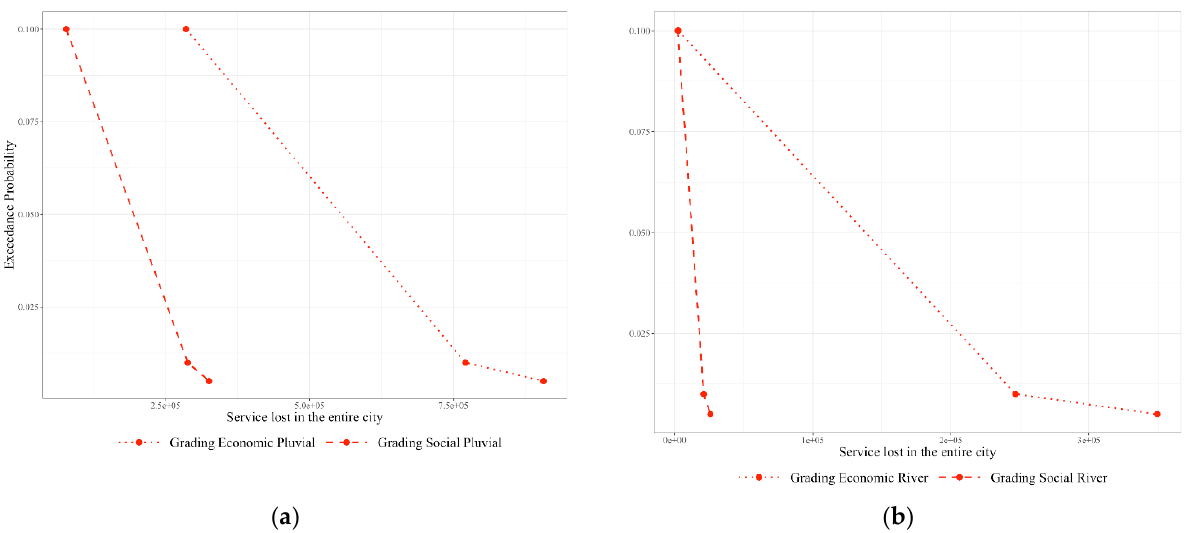
Figure 8. Risk curves for economic and social impacts: ( a ) pluvial, ( b ) river.